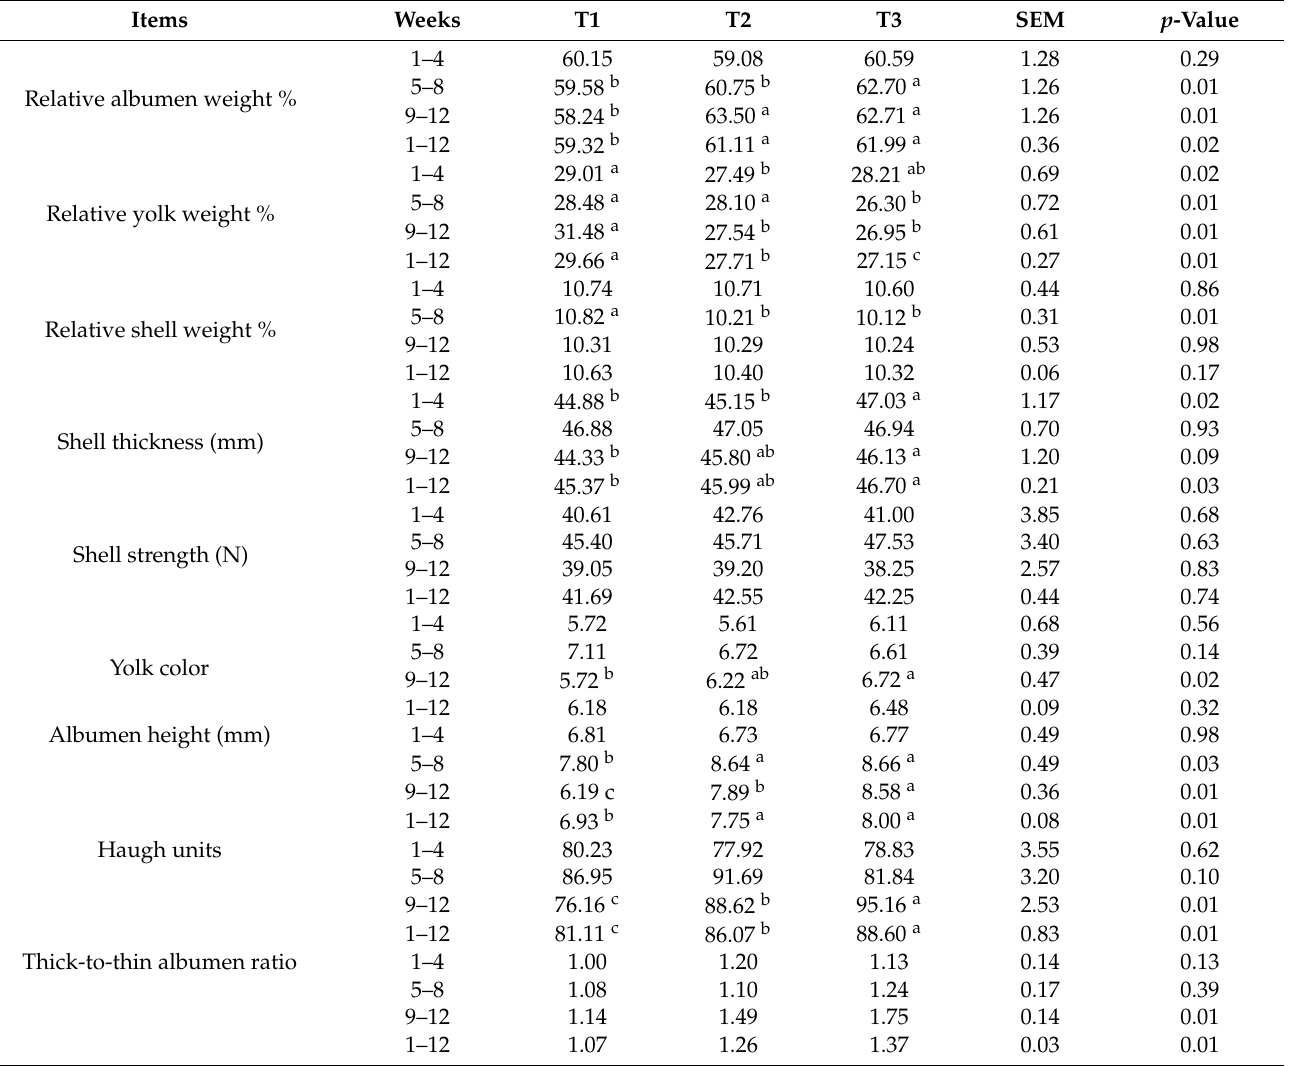
Table 3. Effect of dietary fructooligosaccharides on egg quality of laying